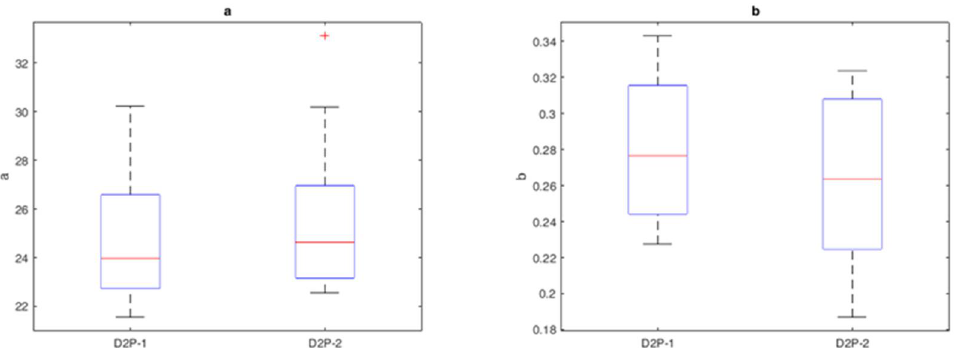
Figure 5. Boxplot with comparison of D2P-1 and D2P-2 estimated parameters .